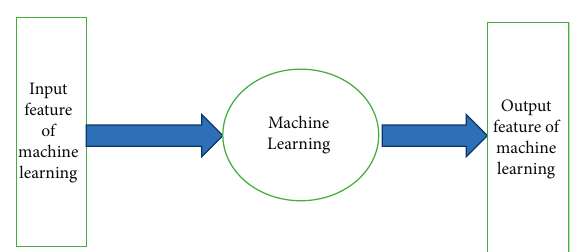
Figure 3: Machine learning 3.3. Gaussian Process Regression. It is the best regression process to solve complex problems with high dimension, nonlinear, and fewer training parameters. So that we will get good performance output by the gaussian process regression